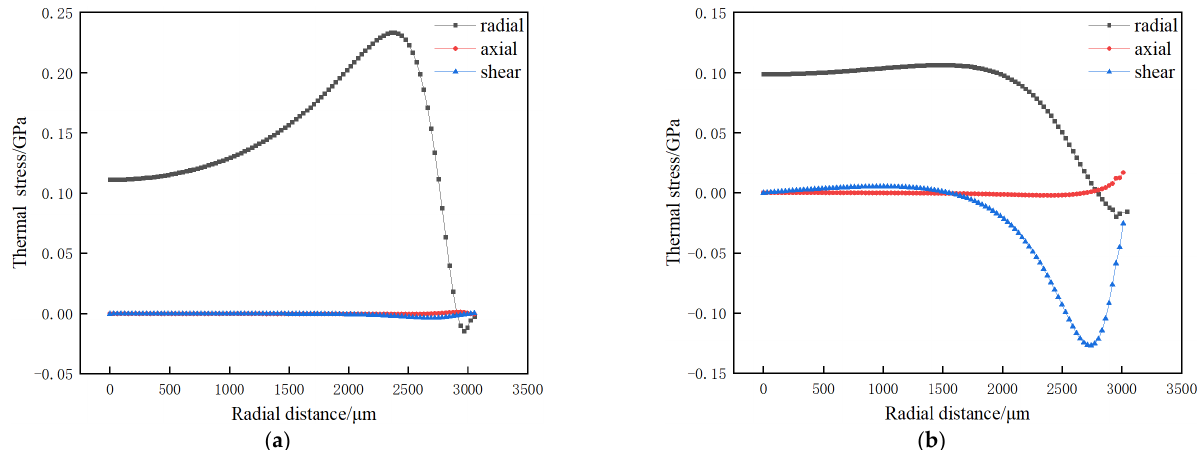
Figure 4. Distribution of thermal stress along the X direction on the surface of the LMA layer of the ( a ) M1 and ( b ) M2S1 specimens at a working temperature of 900 °C.